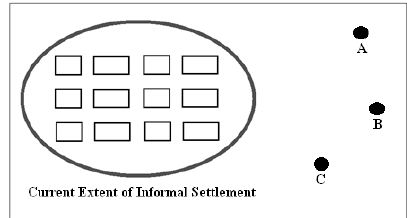
Figure 5. Common Destinations that Placed Outside of